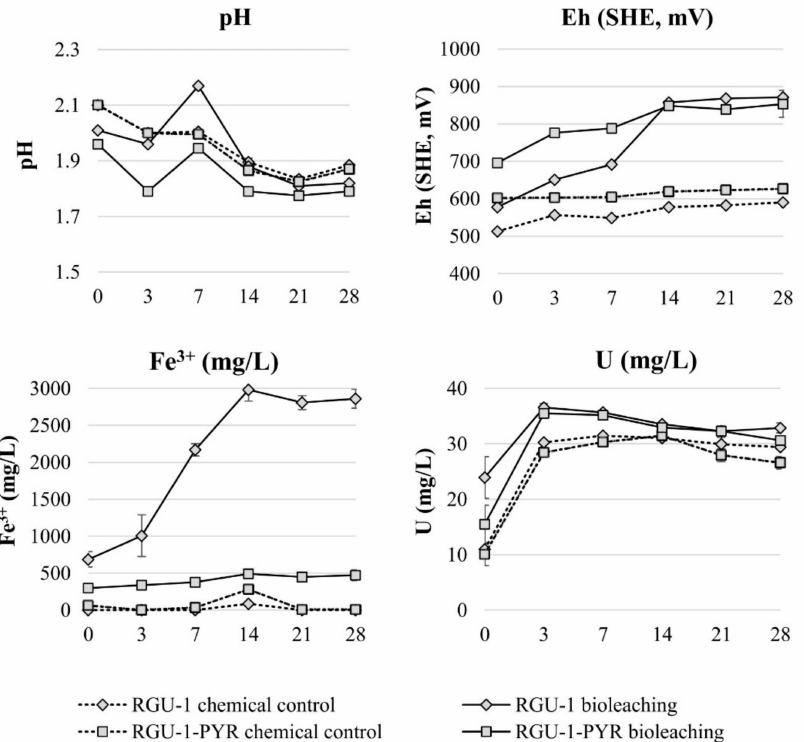
Figure 2. Evolution of pH, Eh and Fe and U concentrations during bioleaching and chemical leaching of RGU-1 and RGU-1-PYR ores. The x-axis represents the leaching duration